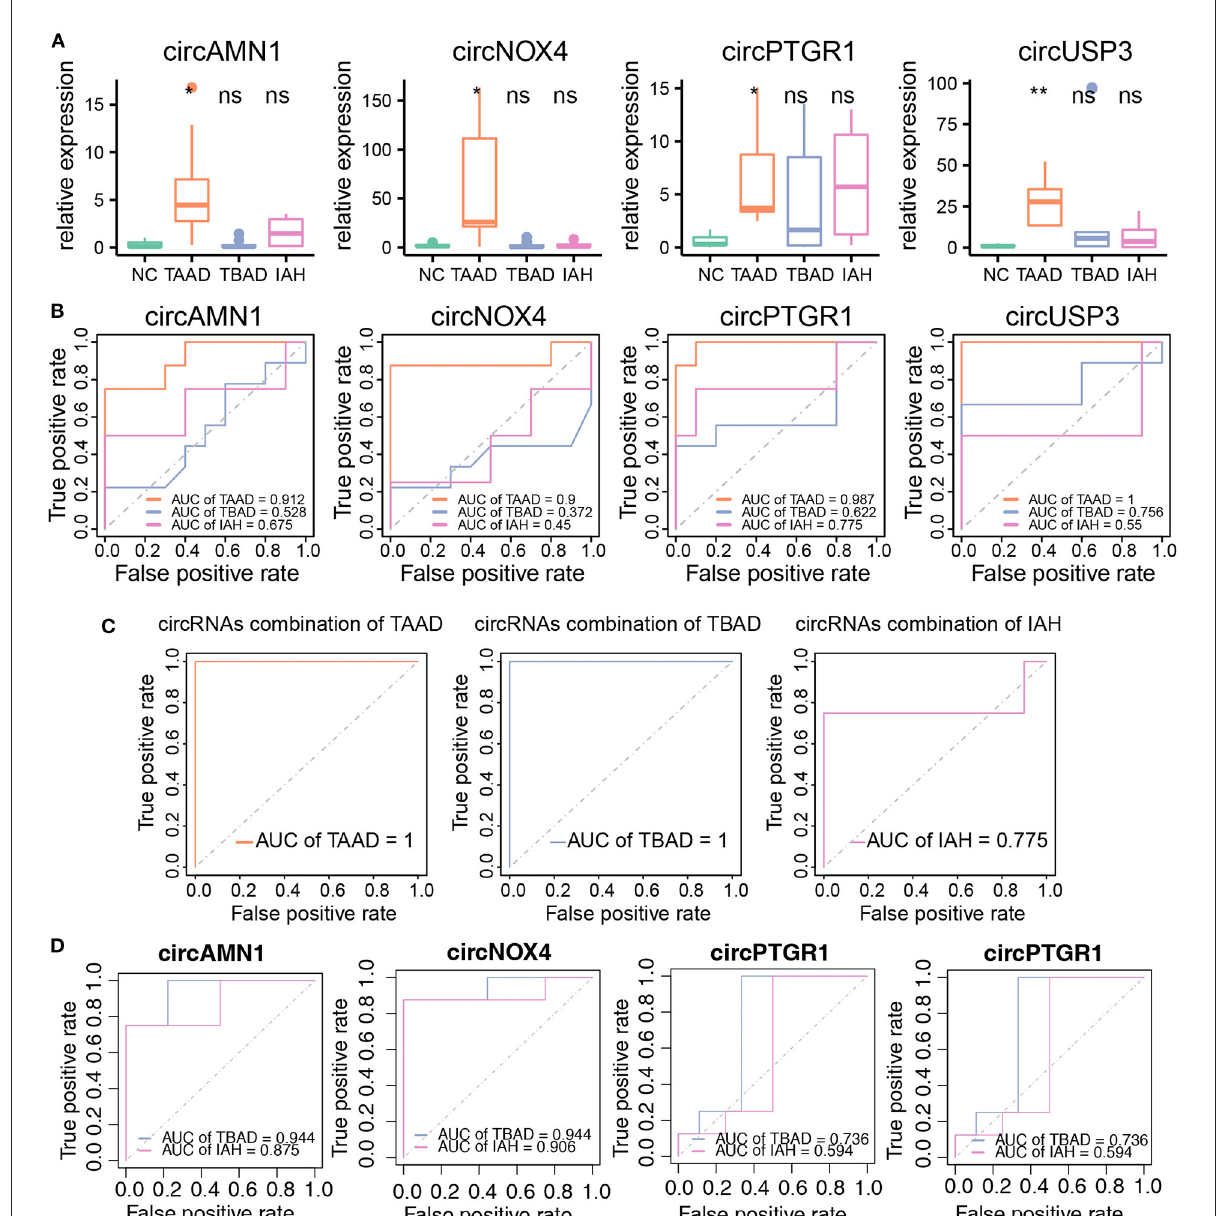
FIGURE6 The circRNAs as biomarkers were efficient to diagnose TAAD in peripheral blood serum. (A) The circRNAs relative expression of NC ( n = 10), TAAD ( n = 8), TBAD ( n = 9), and IAH ( n = 4) in peripheral blood serum. Student’s t -test was utilized to test different disease types compared to NC, respectively. (B) ROC curve analysis of the prognostic prediction efficiency of individual circRNA in TAAD, TBAD, and IAH from NC. (C) ROC curve analysis of the prognostic prediction efficiency of combination circRNAs in TAAD, TBAD, and IAH. (D) ROC curve analysis of the prognostic prediction efficiency of each circRNAs in TBAD and IAH from TAAD. * p < 0.05, ** p < 0.01 (Student’s t